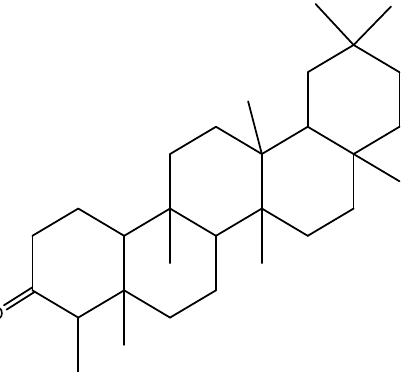
Figure 4. Structure of friedelin 1 isolated from Syzygium cumini bark.